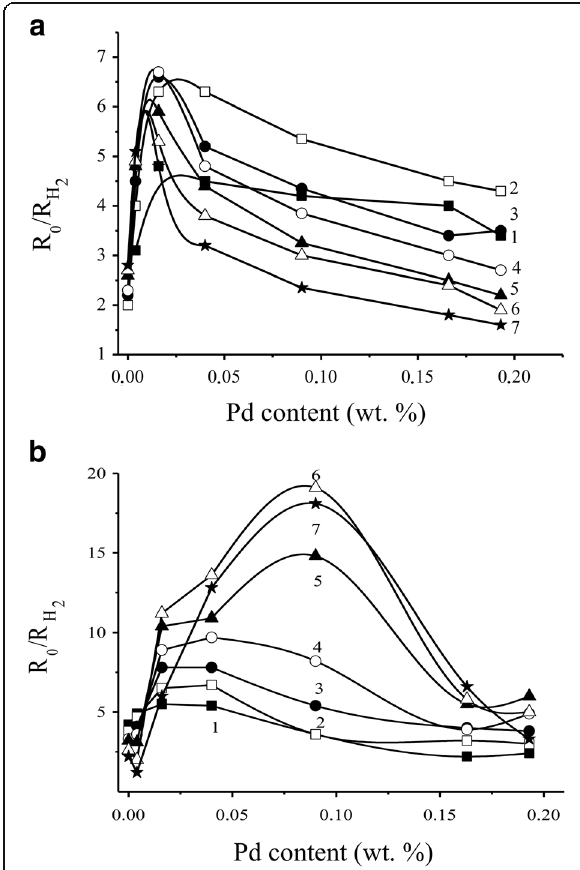
Fig. 5 Dependence of the sensor response to 40 ppm H 2 for the sensors a S 1 and b S 2 based on Pd/SnO 2 on the palladium content at different temperatures of the sensors: 1 410 °C, 2 382 °C, 3 355 °C,